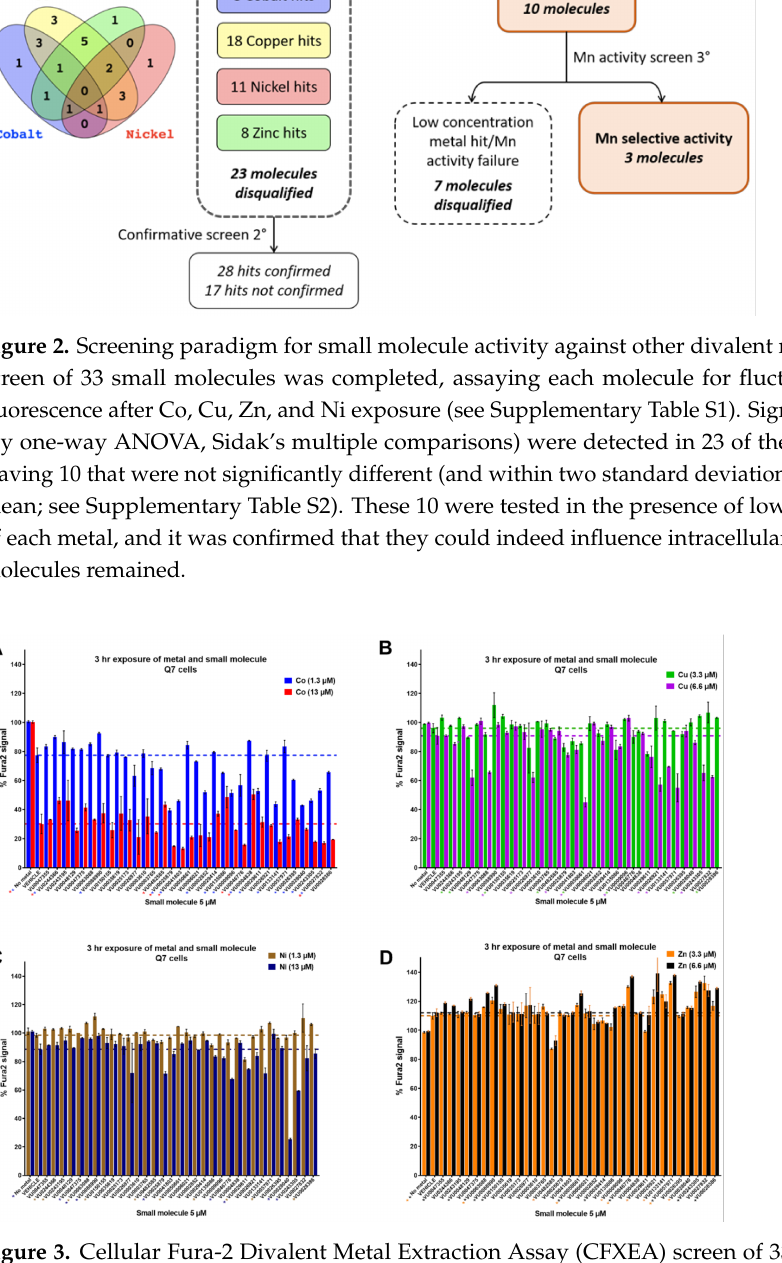
Figure 3. Cellular Fura-2 Divalent Metal Extraction Assay (CFXEA) screen of 33 small molecules from toolbox. Cells were pre-exposed with small molecule (5 µ M), then the metal (( A ): Cobalt, ( B ): Copper; ( C ): Nickel; ( D ): Zinc) was added. After 3 h, the cells were washed with PBS and lysed open with 0.1% Triton containing Fura-2. The presence of divalent metal quenches the Fura-2 signal in a concentration-dependent manner. We compared the Fura-2 signal of metals taken up by cells (Q7s) under vehicle conditions and determined whether the Fura-2 signal was significantly different when cells were co-exposed with a small molecule. Cells were exposed to a small molecule and metal in HBSS. The dotted line shows vehicle levels for a given metal concentration. A one-way ANOVA for each metal concentration tested was run, with post-hoc Dunnett’s T3 multiple comparisons